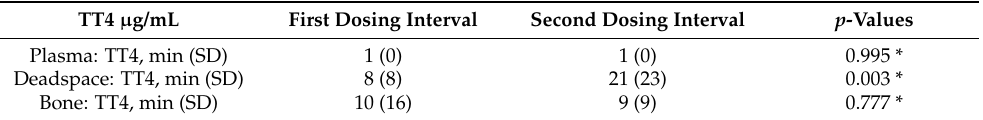
Table 3. A pooled comparison across weight groups of mean time to reach a concentration of 4 µ g/mL for the two dosing intervals for plasma, deadspace and bone. TT4 µ g/mL